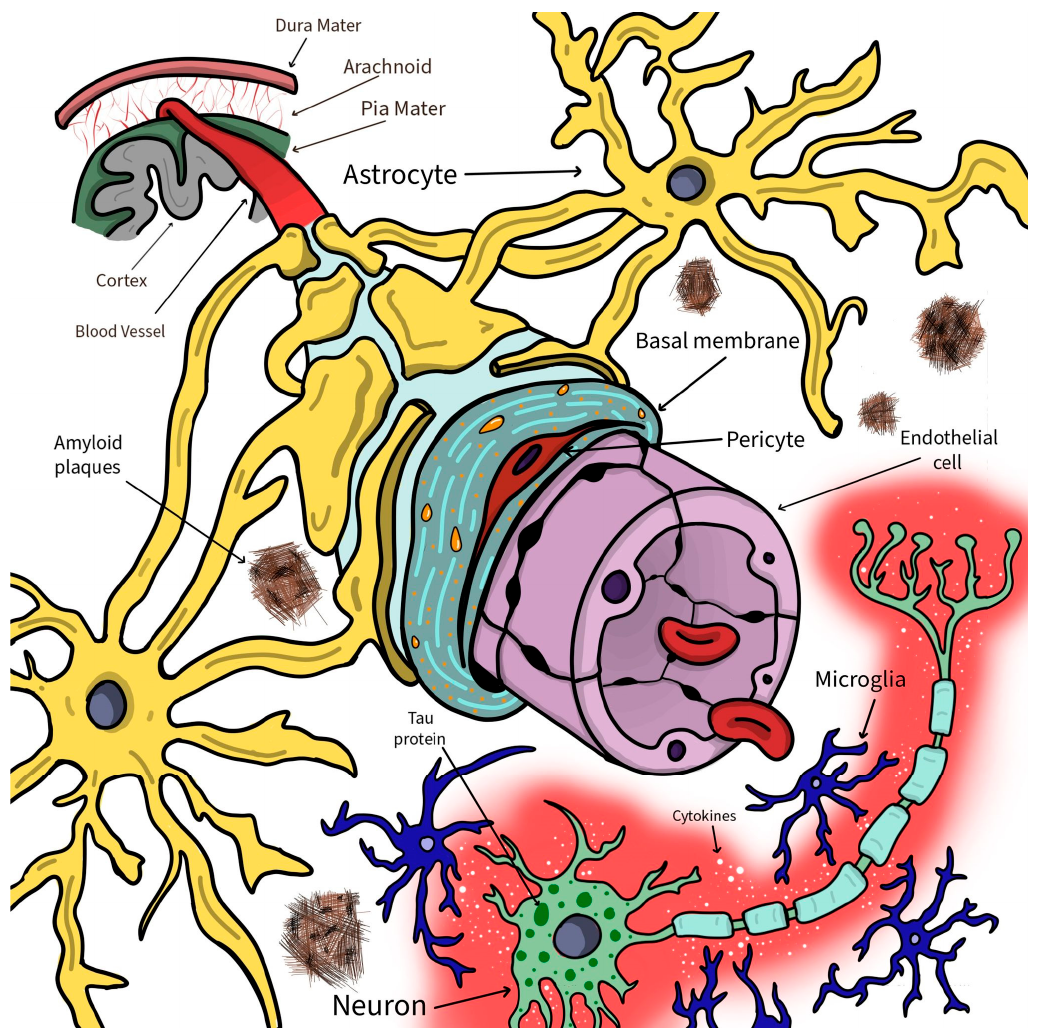
Figure 2. The most relevant pathophysiological changes of the neurovascular unit in AD. Many of the homeostatic processes of the BBB are impaired in Alzheimer’s disease. Vascular integrity is impaired by damage to the endothelial cells (purple), which lose their impermeability in the TJs, along with atrophy of pericytes (red), astrocyte endfeet swelling (yellow), and collagen and laminin accumulation in the basal membrane (blue). Amyloid- β (A β ) builds up and organizes in plaques that surround the astrocytes and neurons. This causes neuroinflammation with the secretion of inflammatory cells and cytokines, with the central role played by microglia (dark blue). Within neurons (green), tau protein accumulates in neurofibrillary tangles (NFTs), which are associated with the accumulation of glial cells and neuronal dysfunction. (Magda Pîr ț ac designed this figure by using Adobe Fresco.)